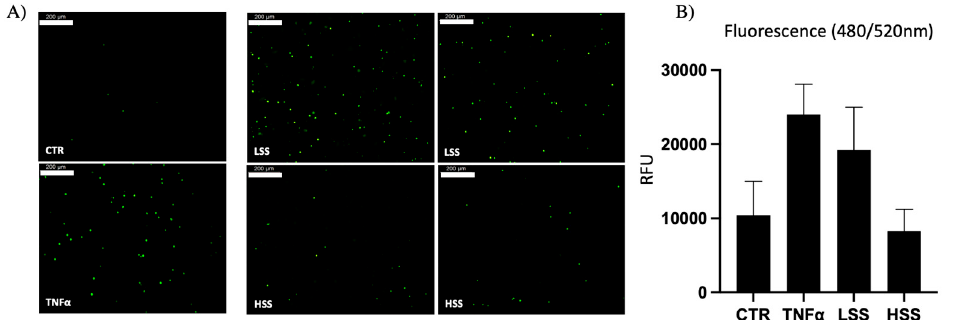
Figure 5. ( A ) PBMC adhesion assay on straight segments of PPFC. ( B ) Quantitative fluorescence analysis. Scalebar: 200 μ m.